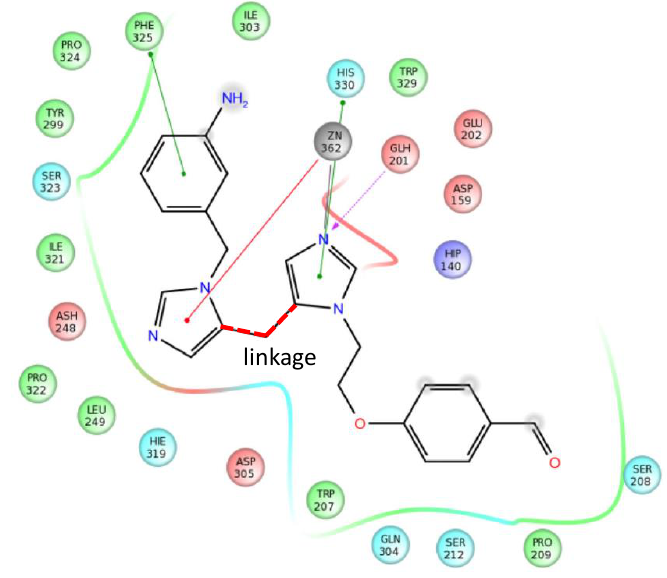
Figure 15. 3D model of the fragment linked to glutaminyl cyclase.